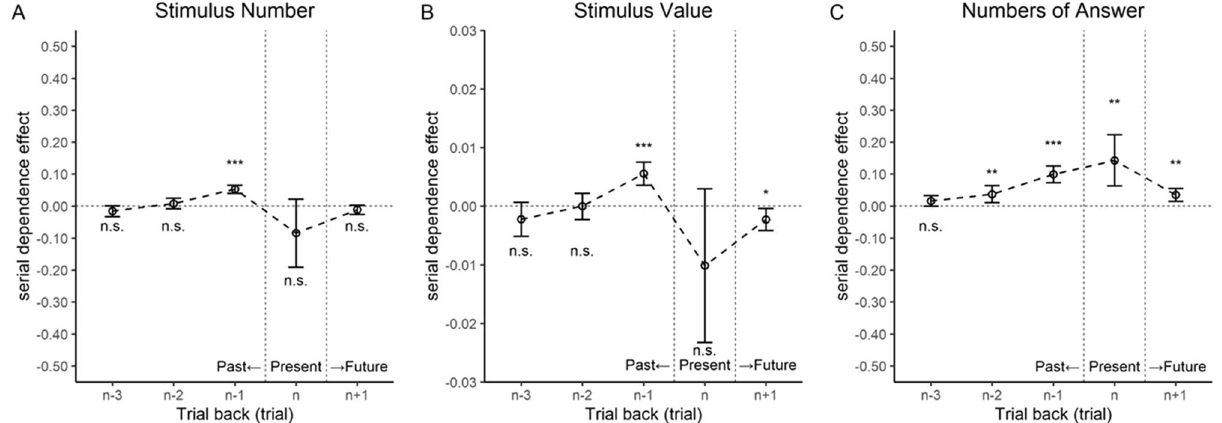
Figure 3. Serial dependence effects in Experiment 1. The y-axes represent the mean error in the participant responses. Positive errors indicate attractive serial dependence. ( A ) Serial dependence effects due to the number of coins presented in previous trials. ( B ) Serial dependence effects due to the monetary value of coins presented in previous trials. ( C ) Serial dependence effects due to the response (number) of the participant in previous trials. The results on the present trial are shown to identify errors due to the stimulus number, monetary value, and responses in previous trials. The results on the n + 1 trial are shown to confirm the autocorrelation of responses. Error bars indicate 95% confidence intervals. Significance levels in the figures are FDR-adjusted p values; n.s. = not significant, * p < 0.05, ** p < 0.01, *** p <